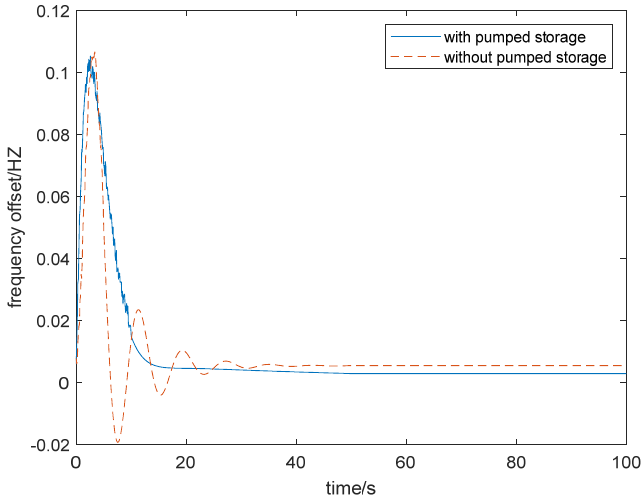
Figure 10. The frequency modulation difference curve of the unit when W = 0.7.